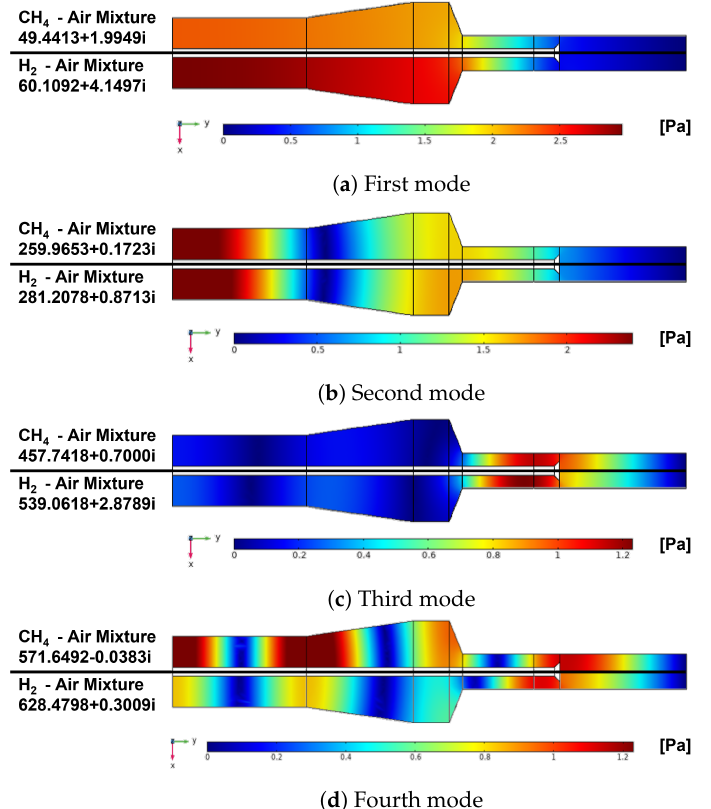
Figure 26. Comparison of the acoustic pressure for the first four modes when the two mixtures (CH 4 –air and H 2 –air) were